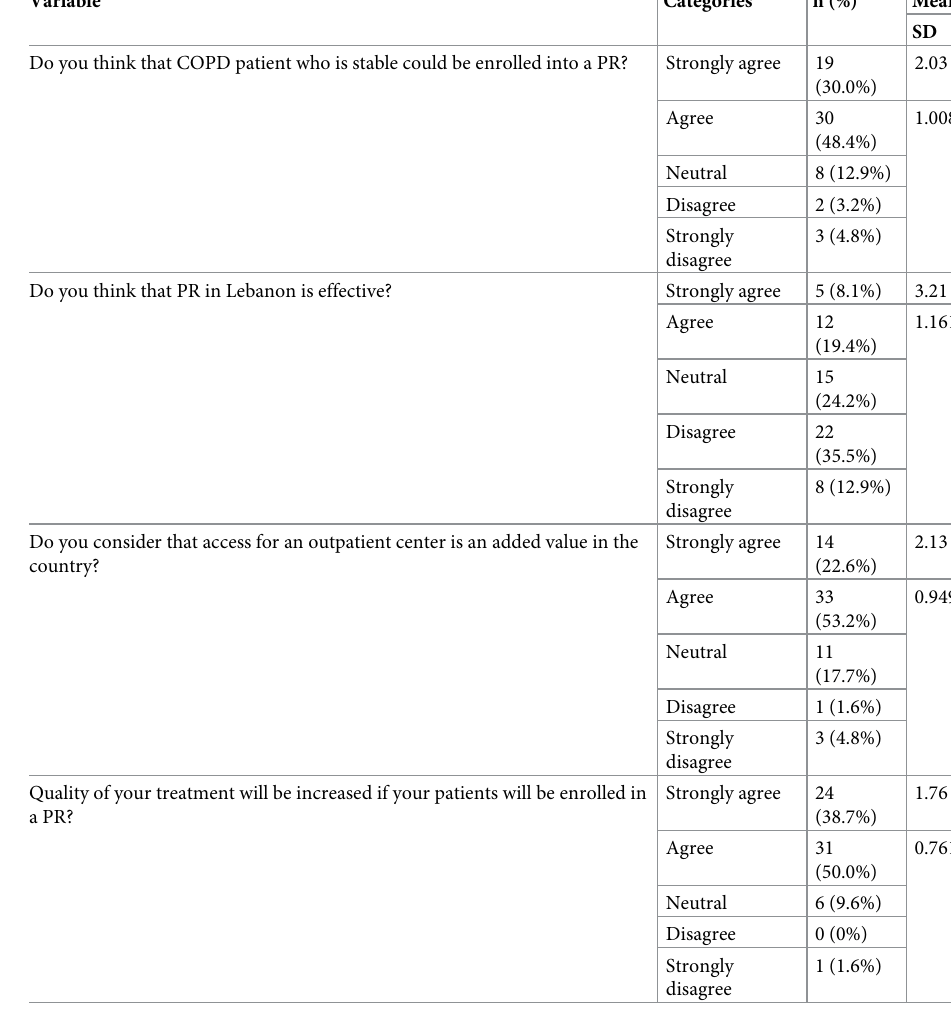
Table 3. Attitude of chest physicians towards pulmonary rehabilitation (PR), N =